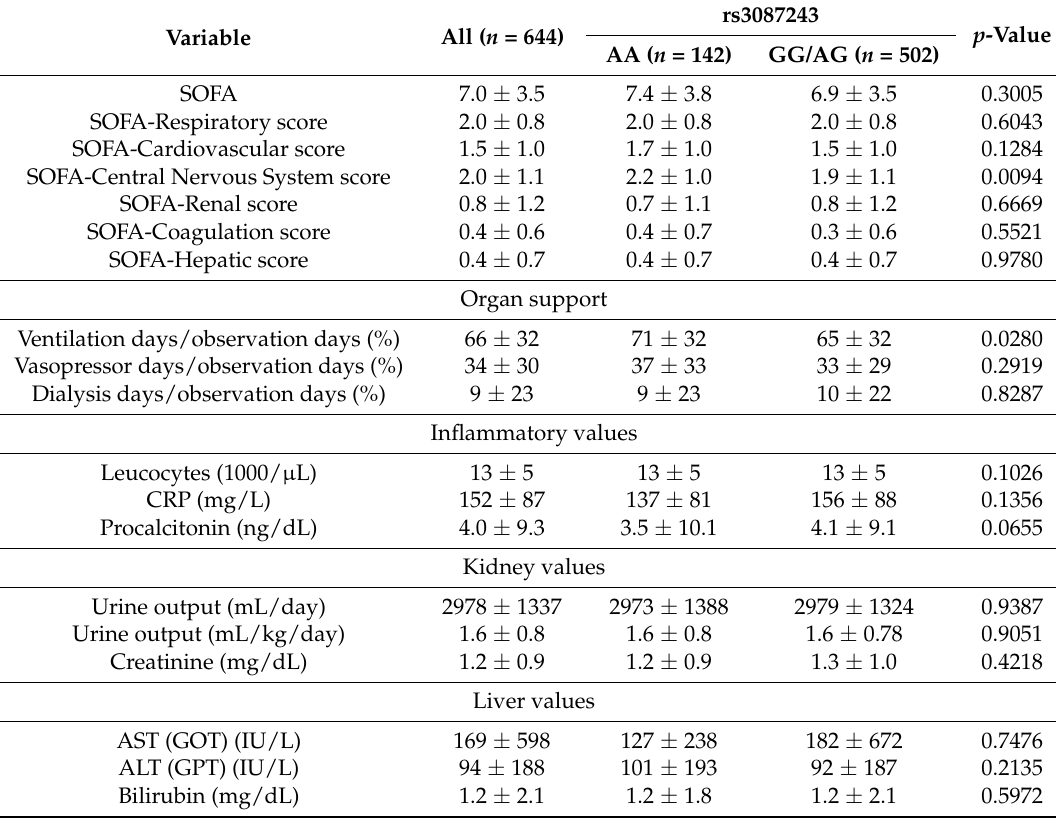
Table 6. Disease severity with regard to the CTLA-4 rs3087243 genotypes.